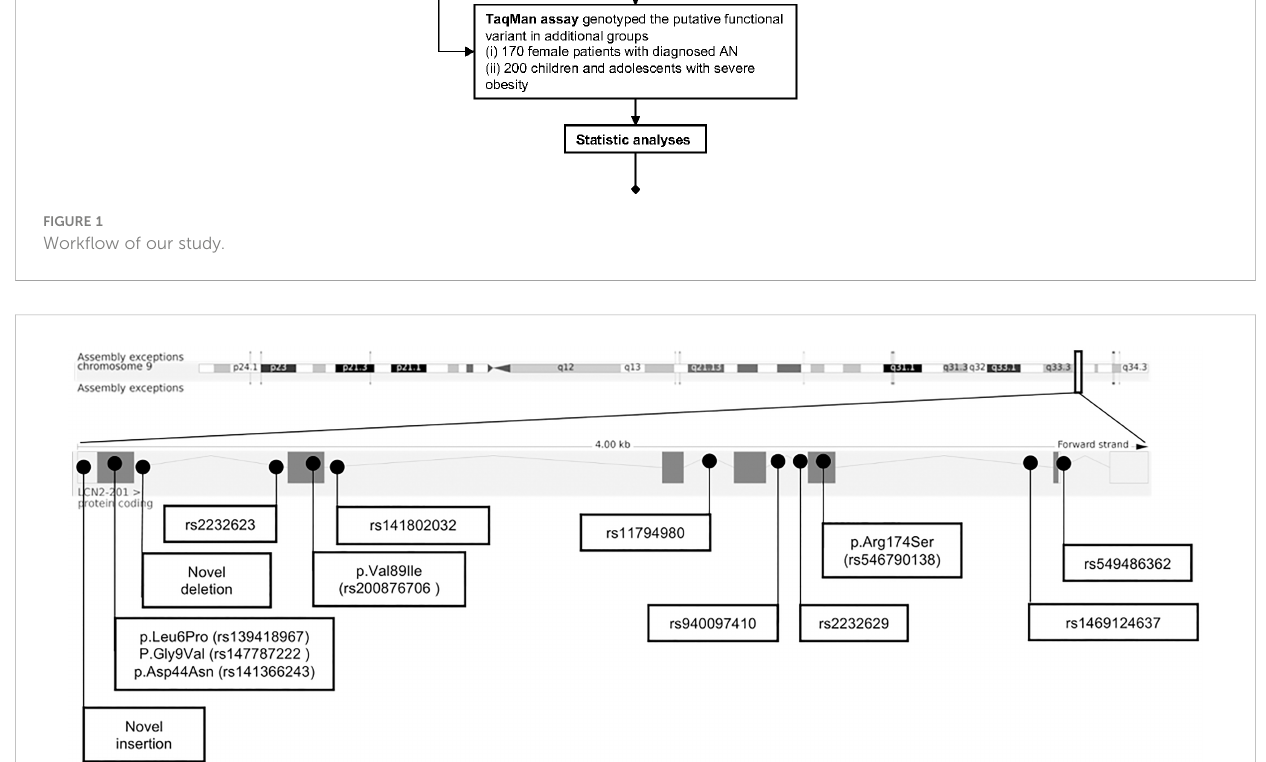
FIGURE 2 Chromosomal structure of LCN2 (GRCh38.p13, Ensembl) and genomic location of 14 detected variants